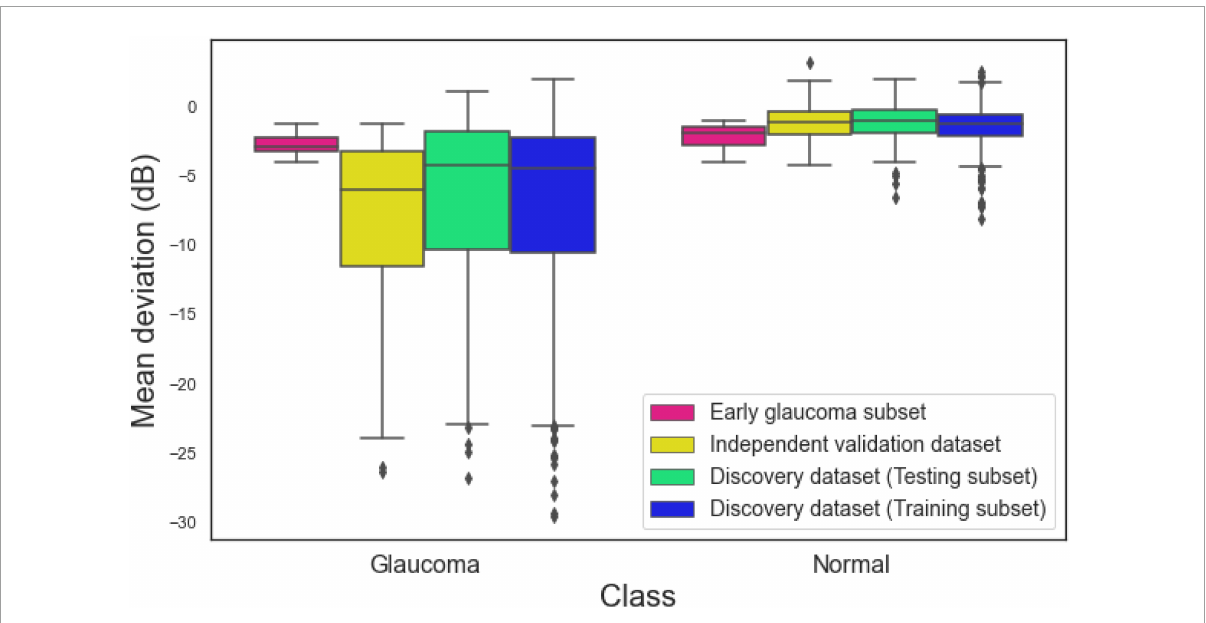
FIGURE2 Mean deviation (MD) of eyes in the training subset of the discovery dataset, testing subset of the discovery dataset, independent validation dataset, and the early glaucoma subset.